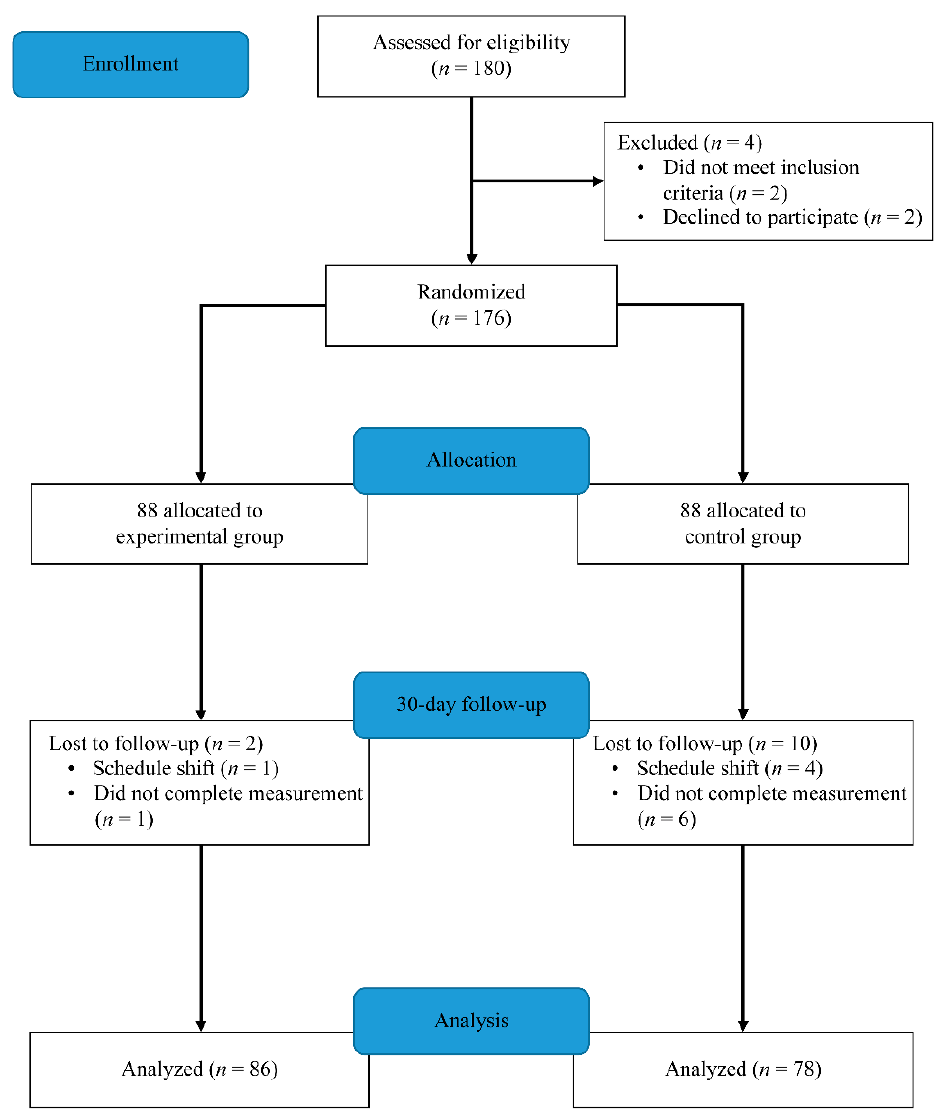
Figure 1. CONSORT flow diagram of the phases of the randomized trial. Table 1. Demographics of the study population (N =